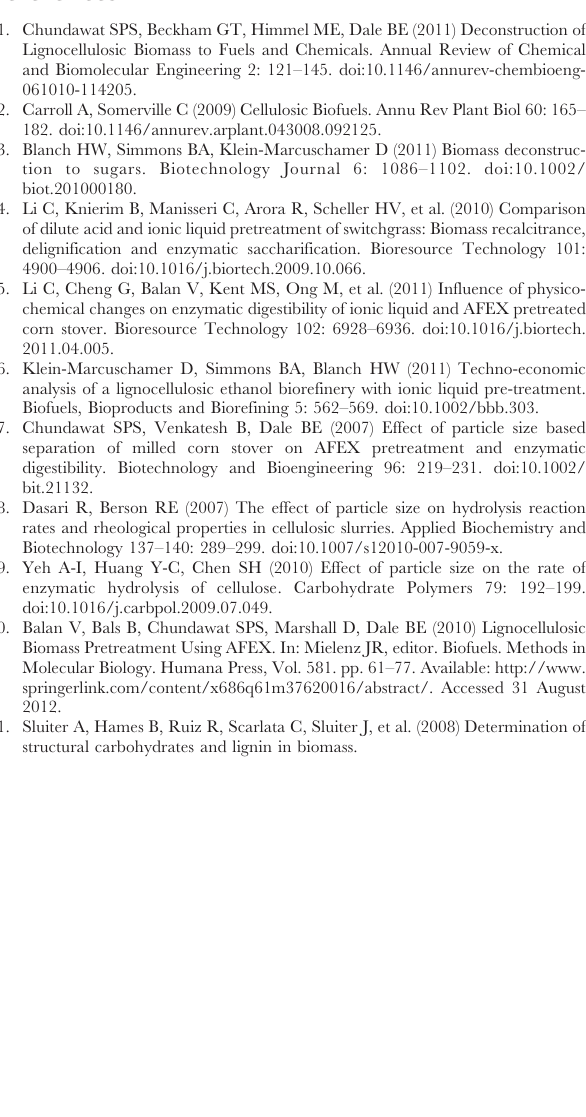
Table S1 Reducing sugar yields after enzymatic saccharification. Data shown are a representation of five independent measure- ments (see Material and